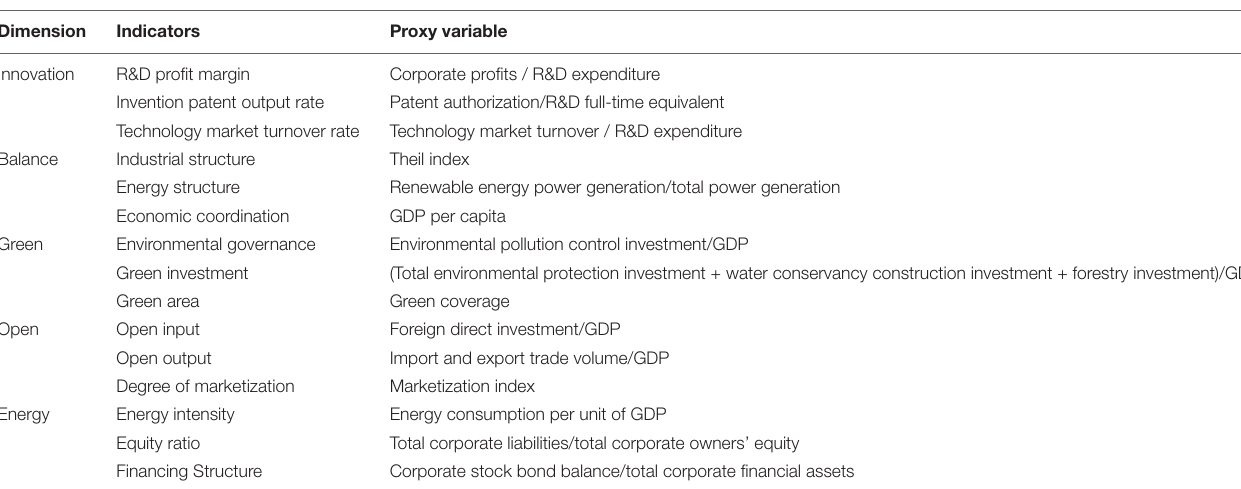
TABLE 2 | Factors of high-quality energy finance